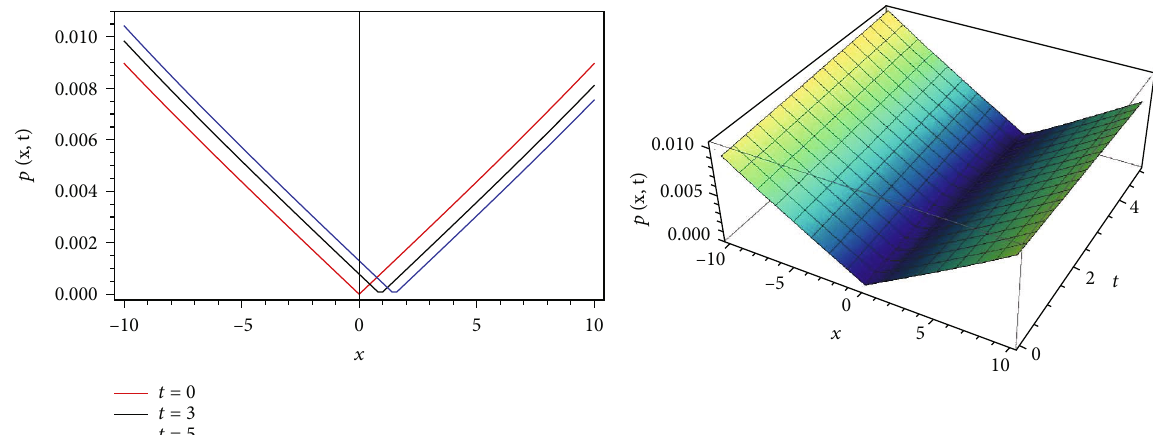
: 4, β : 3, γ : 4, k = 0 : 2, α = 0 : 3, ω j = 0 j = 0 j = 0